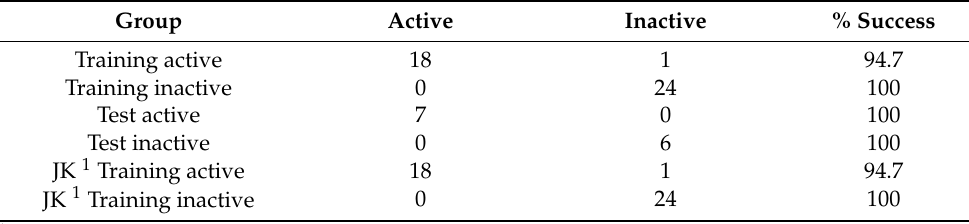
Table 1. Classification matrix for DF MRSA1